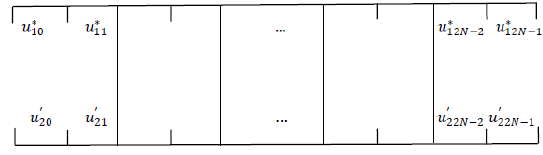
Figure 5. Schema of flowchart part II. b .